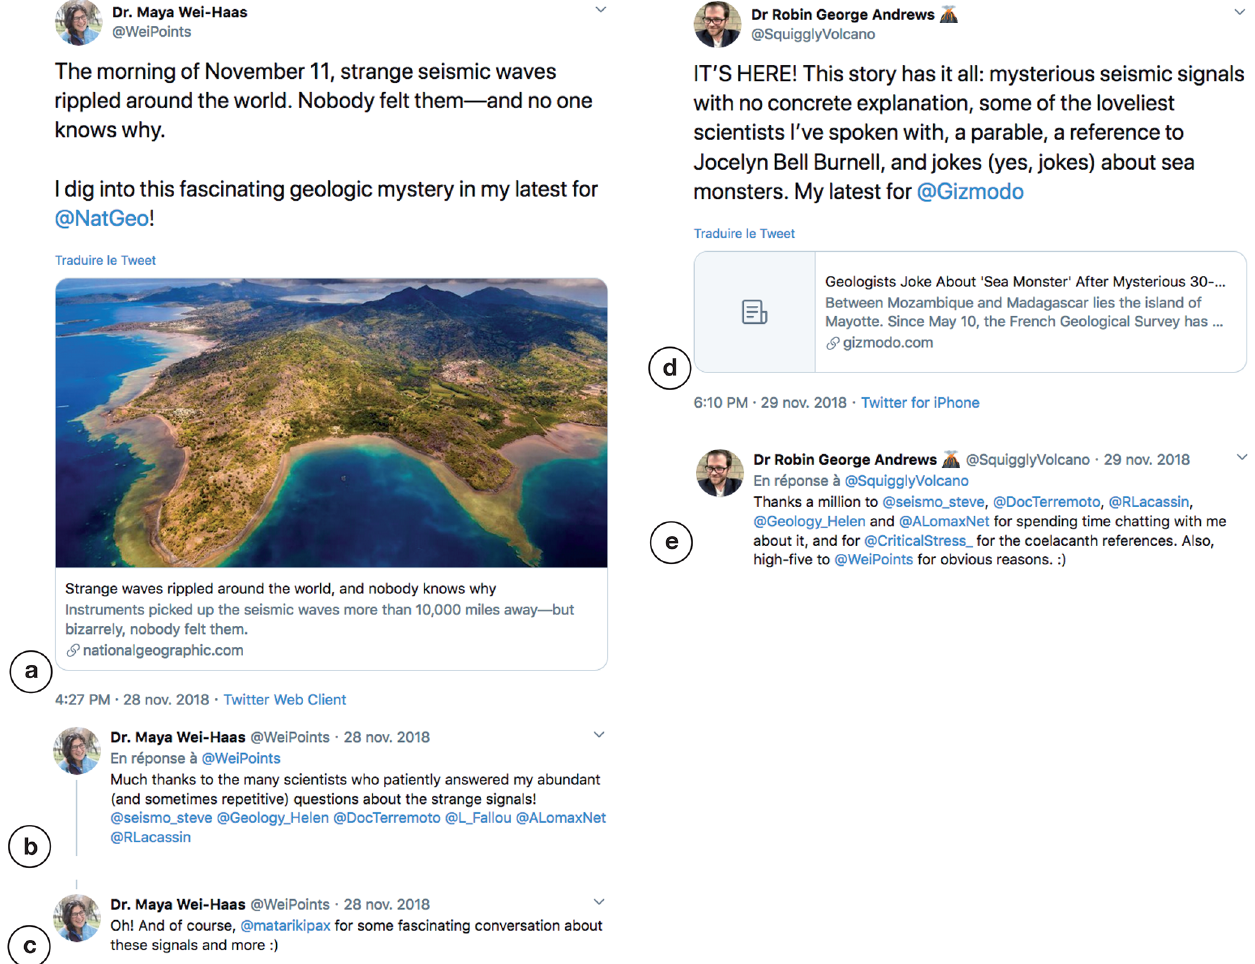
Figure 6. Screenshots of tweets by journalists Maya Wei-Haas and Robin George Andrews. After promoting their media article on the Mayotte 11 November 2018 event (a, d) , the journalists acknowledged academic researchers who were first identified and contacted via Twitter and then interviewed via email or phone (b, c, e)